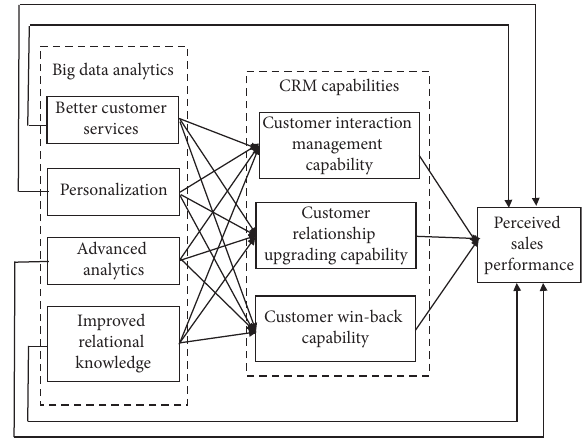
Figure 1: Research